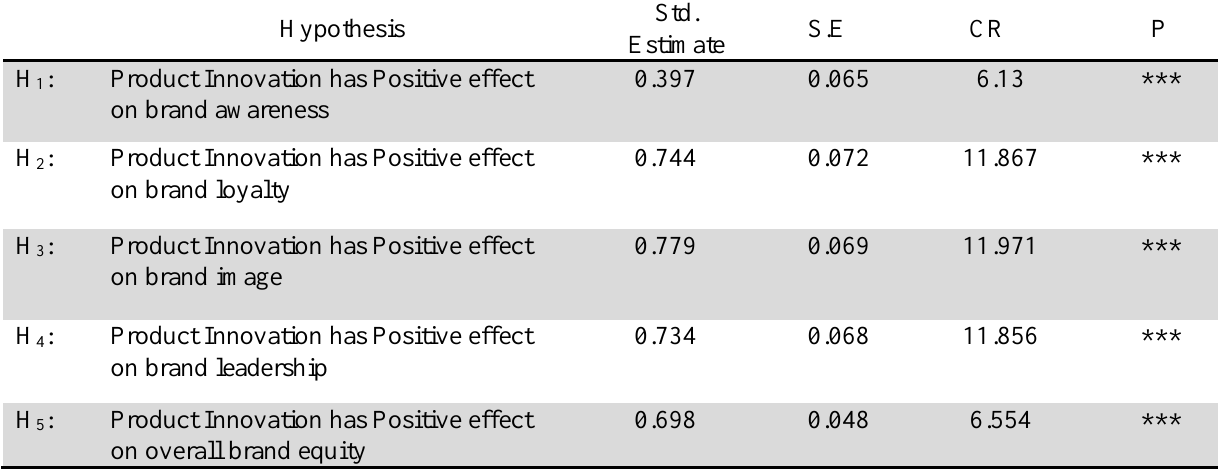
Regression Analysis